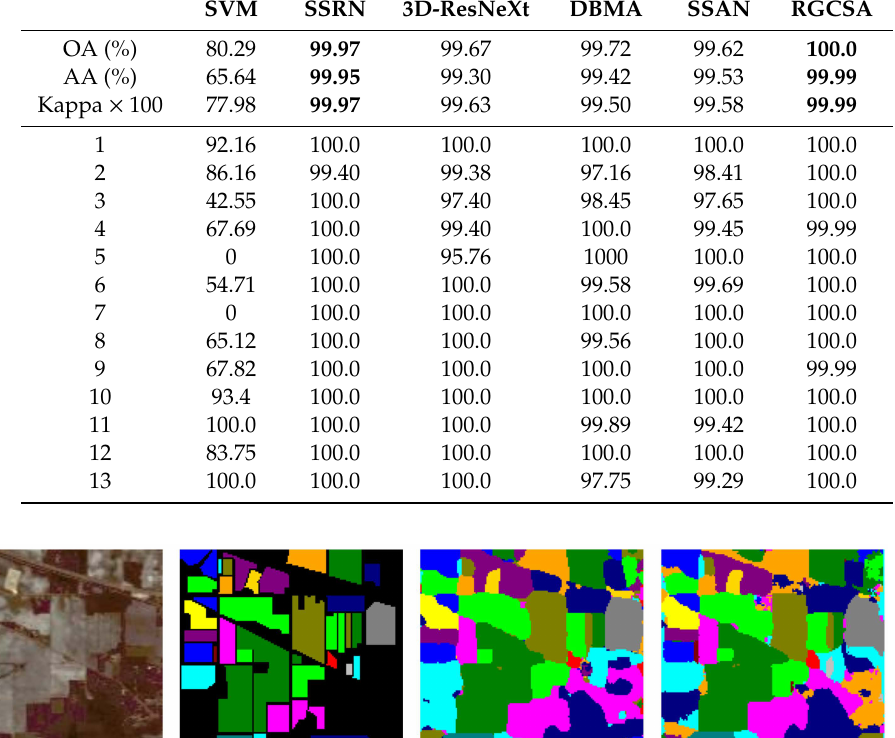
Table 13. Classification results of di ff erent methods for the KSC dataset.